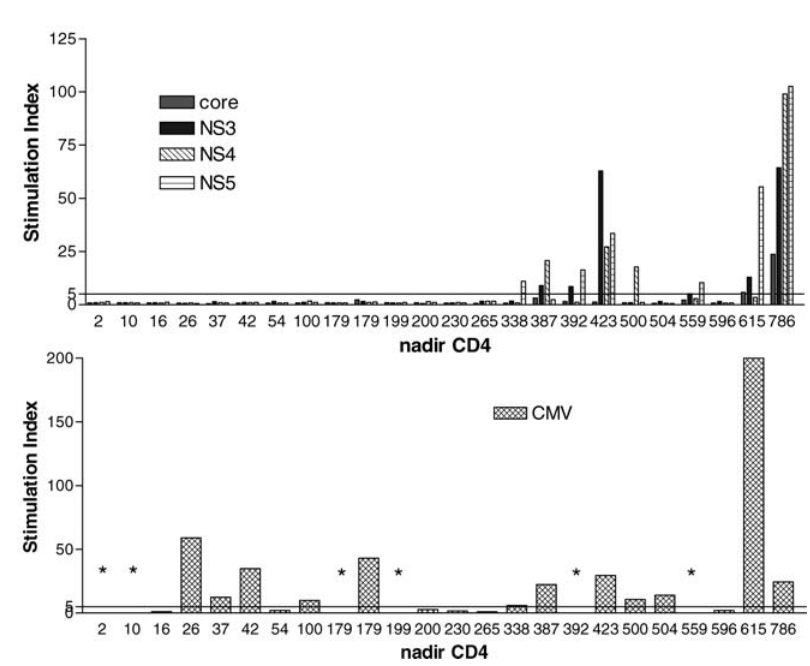
Figure 4. LP Responses in HIV þ Participants Who Spontaneously Control